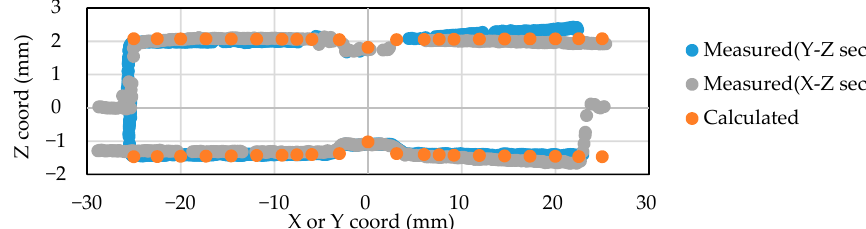
Figure 10. Comparison of the scanned geometry and the calculated one for identifying inherent deformation.